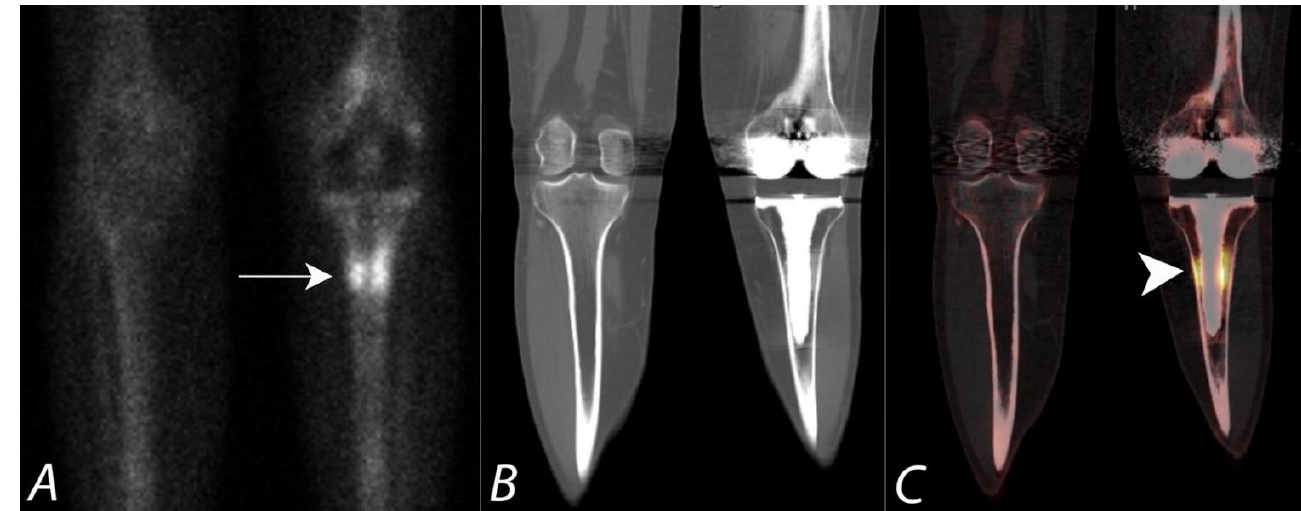
Figure 9. Fifty-year-old female with a painful left knee prothesis. Anterior planar ( A ), coronal CT ( B ) and coronal SPECT/CT ( C ) images of a Tc-99m MDP bone scan of both knees demonstrate a prominent increased uptake in a band surrounding the midportion of the left tibial prosthetic stem. Plain AP radiographs demonstrate sclerosis without periprosthetic lucency. Findings are consistent with being related to altered biomechanical remodeling (similar to a stress fracture). There is no evidence for loosening or infection.